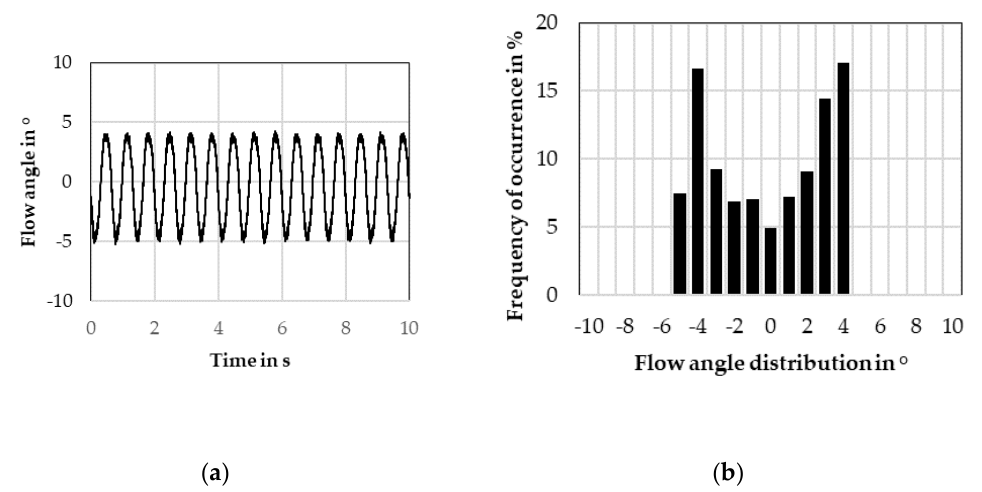
Figure 3. ( a ) Flow angle time history for a sine signal ( 𝑓 = 1.5 Hz, 𝐴 = 4.4°); ( b ) Flow angle probability distribution for the same signal.